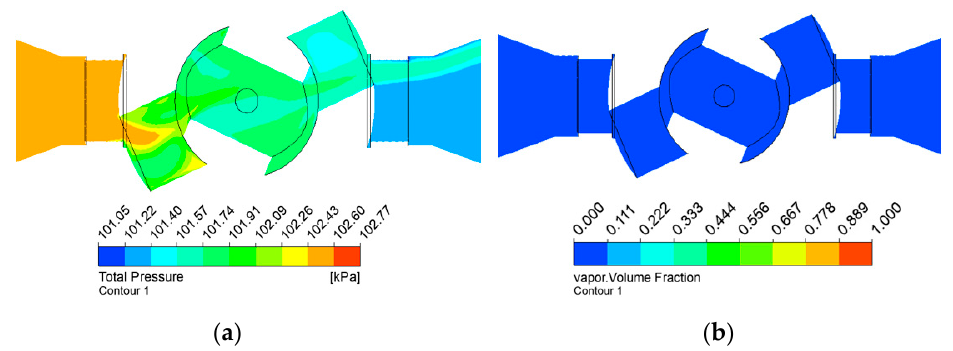
Figure 9. Contour plots of the pressure and vapor volume fraction for the proposed cylinder-in-ball valve at an opening rate of 20%: ( a ) pressure; ( b ) vapor volume fraction.